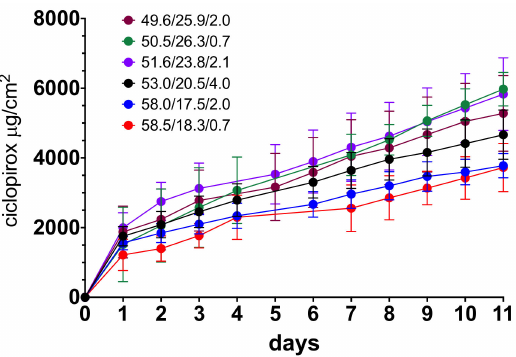
Figure 3. Di ff usion kinetics of ciclopirox base through bovine hoof. Symbols indicate the ethanol / water / ethyl acetate proportion in the blends.